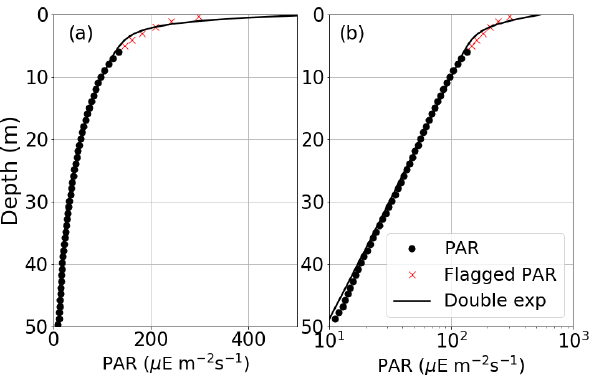
Figure 2. (a) Profile of PAR (black circles) measured from float 629 from the surface to 50m of depth with a fitted double expo- nential function (black line) to PAR between 5 and 100m of depth. R and h 1 were specified to be 0.67 and 1.0m, respectively. Red crosses show flagged PAR values that were excluded from the curve fit. (b) Same vertical profile of PAR and fitted double exponential function as (a) , but presented in log